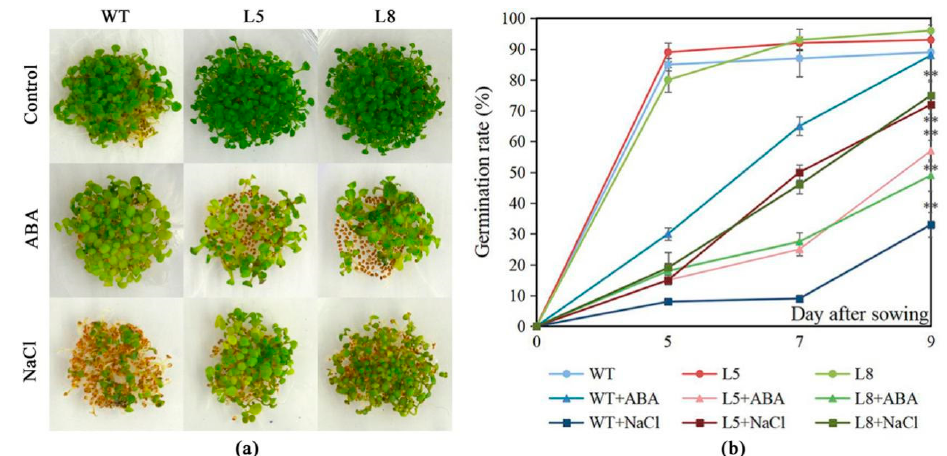
Figure 5. Hypersensitivity and enhancing tolerance of LlMYB3 transgenic lines to ABA and NaCl. Germination of WT seeds of Col-0 and 35S:LlMYB3 on MS supplemented with 50 mM NaCl and 2 μ M ABA after 9 days of incubation at 22 °C ( a ). Germination rate of seeds counted after 5, 7 and 9 days after sowing. The data represent the means from three experiments. The bars show the SD. di ff erences between the transgenic and WT lines are indicated as ** p < 0.01. Significant differences between the transgenic and WT lines are indicated as ** p < 0.01.